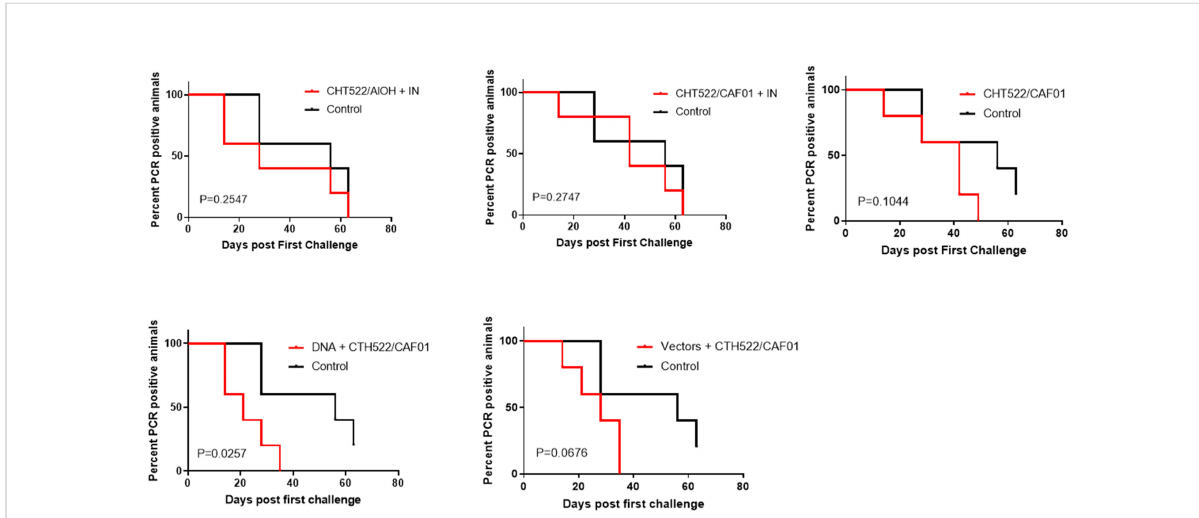
FIGURE 7 Clearance of vaginal C. trachomatis challenge infection Cynomolgus macaques were immunized following different prime-boost regimes ( n = 5 per group) and subsequently given a vagino-cervical challenge infection with 5*10 7 IFUs C. trachomatis SvD. After the inoculation, vaginal swabs were collected for the following nine weeks. The vaginal chlamydial load was determined by qualitative PCR on swab